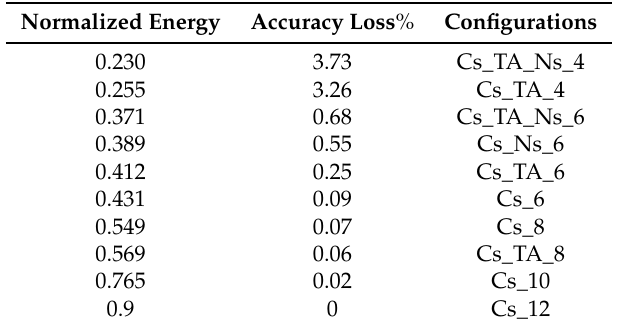
Table 1. power and accuracy regions for the MNIST dataset.